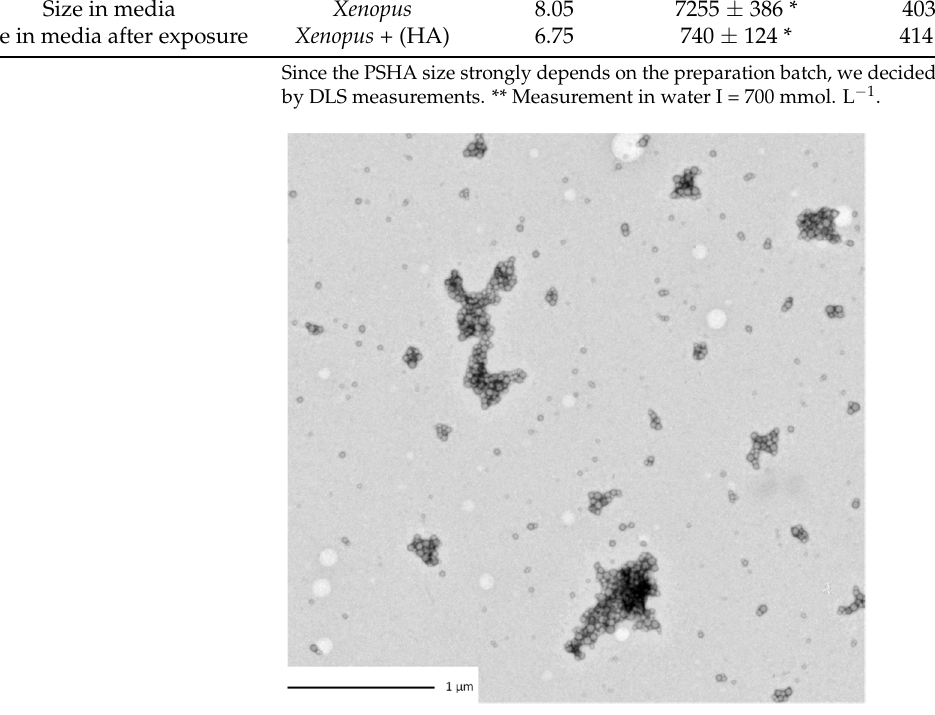
Figure 1. TEM observation of PS50 homoaggregation in Chironomus exposure media.